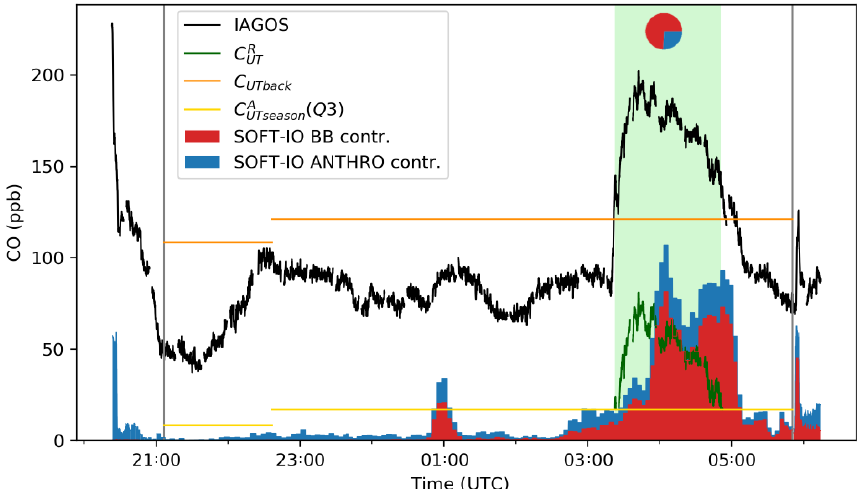
Figure 3. Example of SOFT-IO contributions as well as illustration of the method to calculate CO anomalies (see Eq. 1). The selected flight took off from Frankfurt (Germany) on 13 January 2013 at 20:23UTC and landed in Windhoek (Namibia) the next day at 06:14UTC. The contribution is here at 74% from biomass burning, of which 97% are from NHAF (not shown). The two vertical grey lines represent the end of the ascent and the beginning of the descent of the plane. The CO anomaly (in green) is displayed only when it is superior to the third quartile of